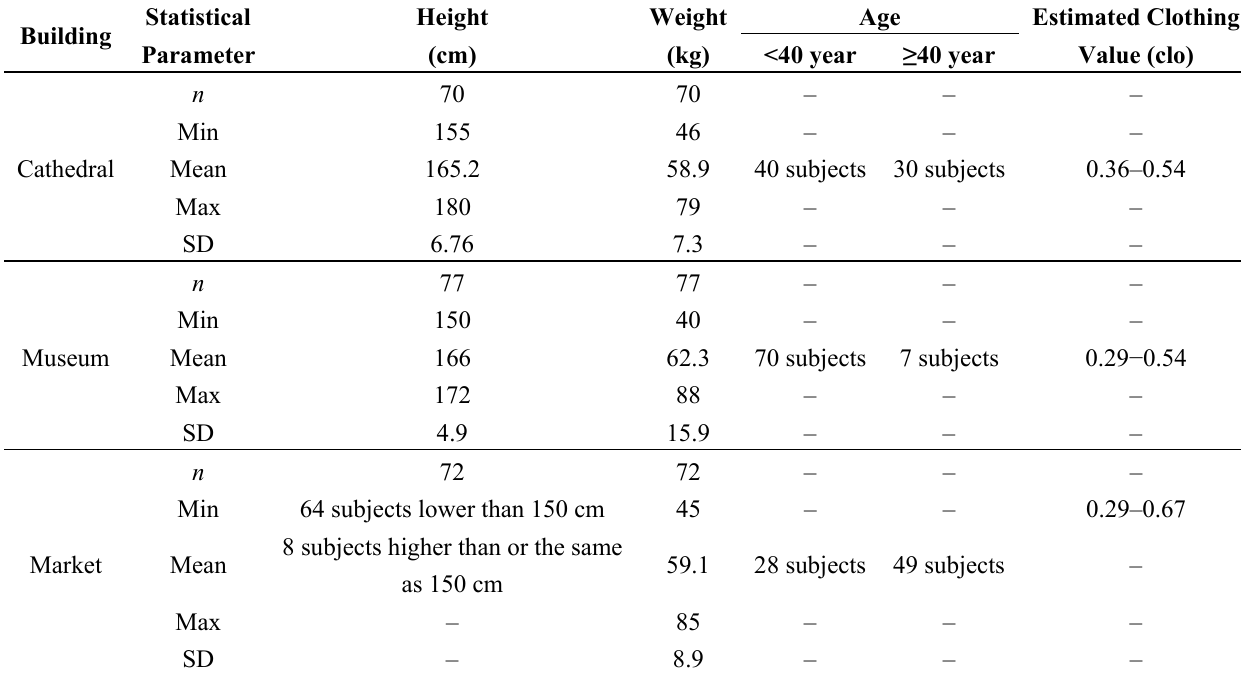
Table 1. Statistical data of the subjects in the three naturally ventilated (NV) buildings.